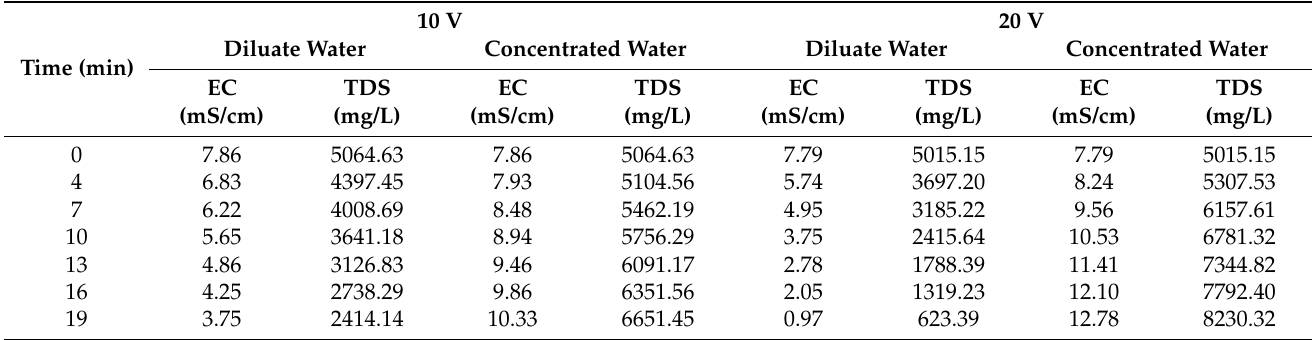
Table A4. Desalination results for the 5000 mg/L TDS sample at 25 ◦ C.